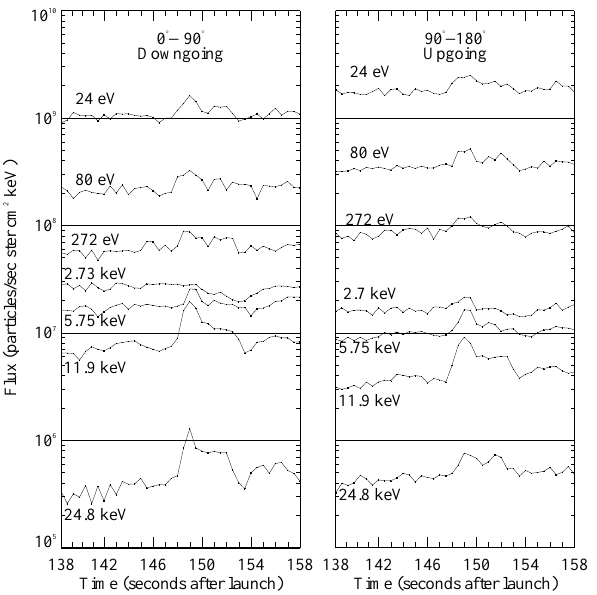
Fig. 5. Flux for the pulsation observed at 146s after launch for selected energies at 0 ◦ –90 ◦ and 90 ◦ –180 ◦ pitch-angle electrons.